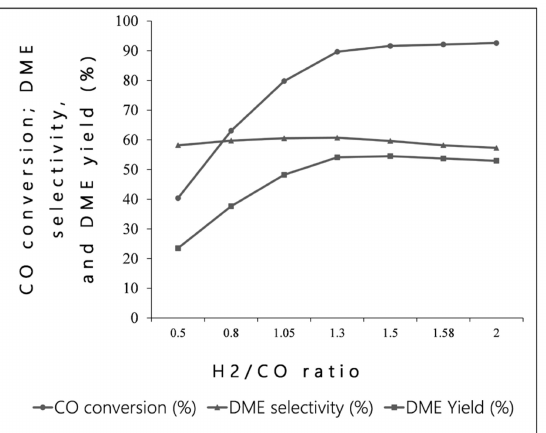
Figure 8. Influence of the H 2 to CO ratio on CO conversion, DME selectivity, and DME